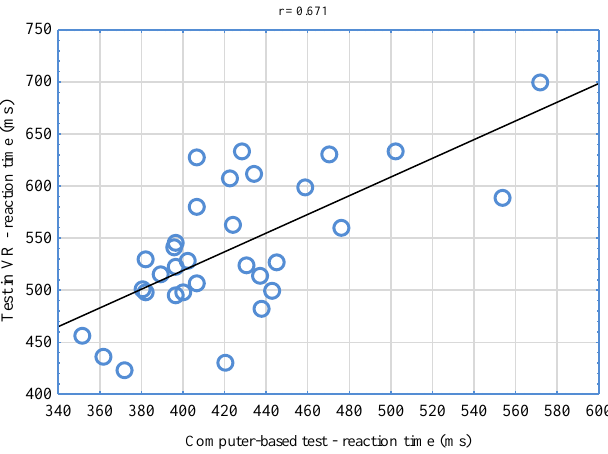
Figure 8. Correlation of the results of complex reaction tests in VR and computer-based ones. Intraclass correlation coefficients ICC for VR-implemented reaction tests and computer-based tests reached a similar level. All correlations were statistically significant ( p < 0.001). In the case of computer-based simple RT tests of the right hand, a slightly lower